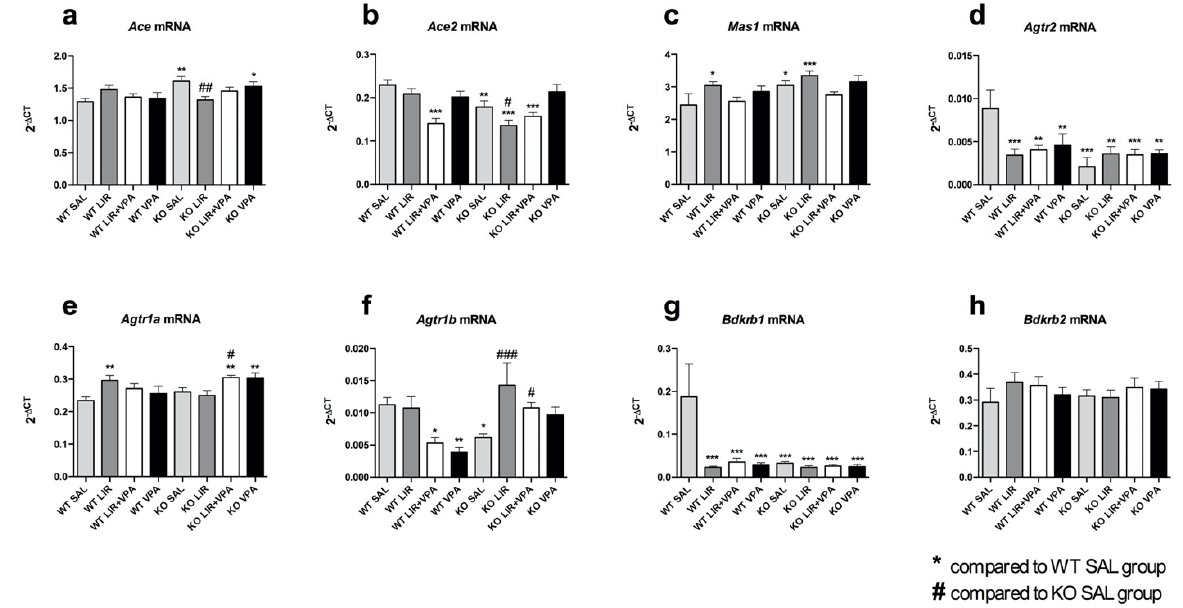
Figure 2. In the heart, in Wfs1 -deficiency there is extensive downregulation of Agtr2 and Bdkrb1 . Gene expression analyses were performed from the heart of 3.5–4-month-old animals after 8 days of treatment with liraglutide (LIR), valproate (VPA), liraglutide + valproate (LIR + VPA), or saline (SAL). The relative expression level was detected for ( a ) Ace mRNA, ( b ) Ace2 mRNA, ( c ) Mas1 mRNA, ( d ) Agtr2 mRNA, ( e ) Agtr1a mRNA, ( f ) Agtr1b mRNA, ( g ) Bdrkb1 mRNA and ( h ) Bdrkb2 mRNA. Gene expression level is presented as 2 −Δ CT relative to the housekeeper Tbp . Data were compared using factorial ANOVA followed by Fisher’s LSD post-hoc tests; * p < 0.05; ** p < 0.01; *** p < 0.001 compared to WT vehicle (SAL) group and # p < 0.05; ## p < 0.01; ### p < 0.001 compared to KO vehicle (SAL) group. The data are presented as the mean ± SEM, n = 8 per group.